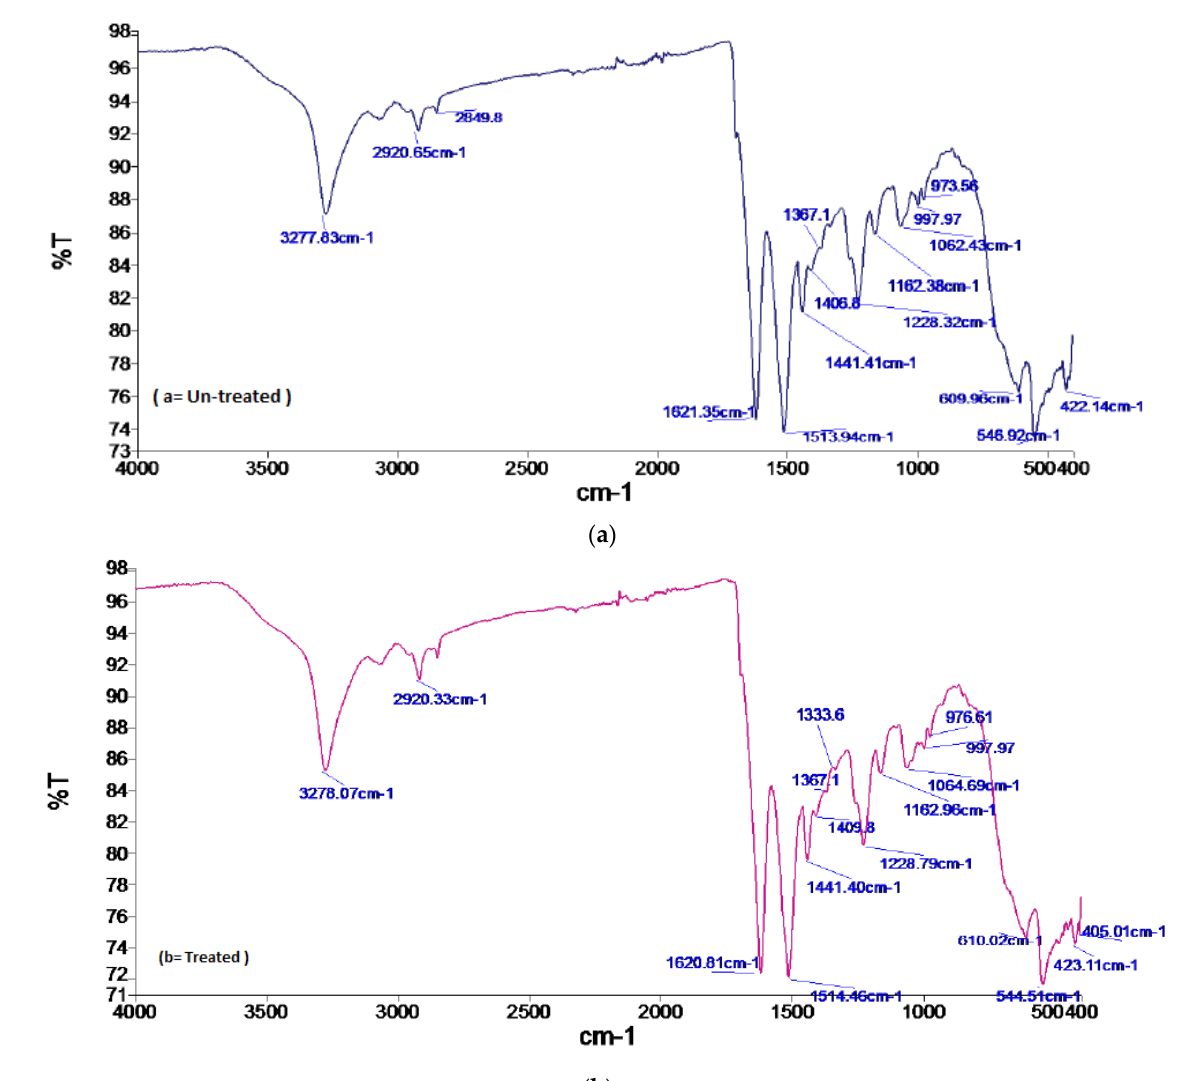
Figure 2. ( a ) Utilization of microwave irradiated and un-irradiated aqueous ( a ) and acidic extract ( b ) of red sandalwood (RSW) powder for dyeing irradiated and un-irradiated silk fabric.